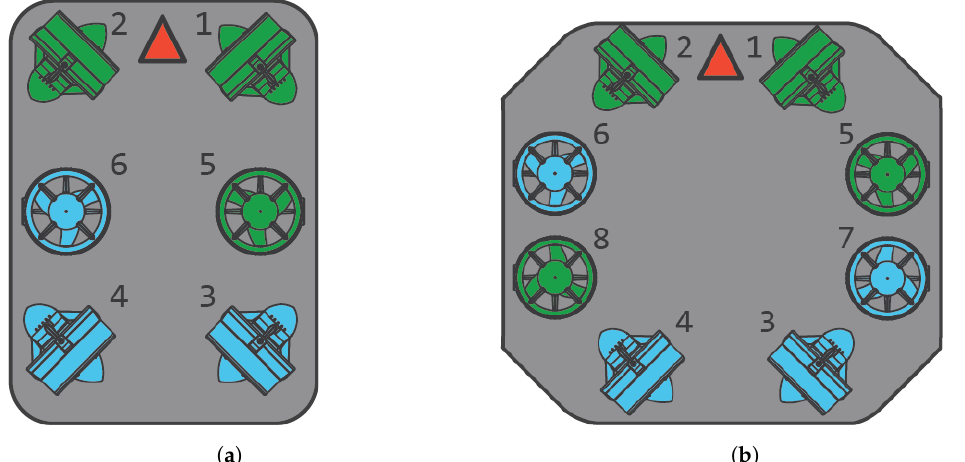
Figure 3. A comparison of the thruster configuration of the normal and heavy BlueROV2. The blue thrusters are the clockwise thrusters, and the green are the counterclockwise thrusters. The red arrow is the positive surge direction [25]. ( a ) BlueROV2 normal configuration. ( b ) BlueROV2 heavy configuration. Table 2. Difference between thruster combination to motion on normal and heavy configuration.